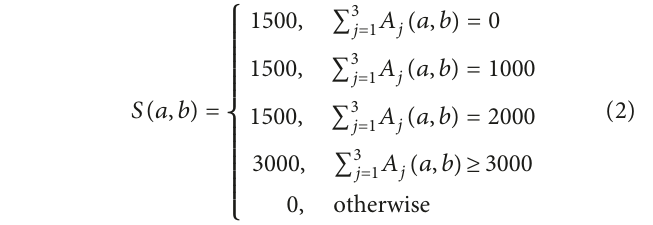
Table 6: Matrix A